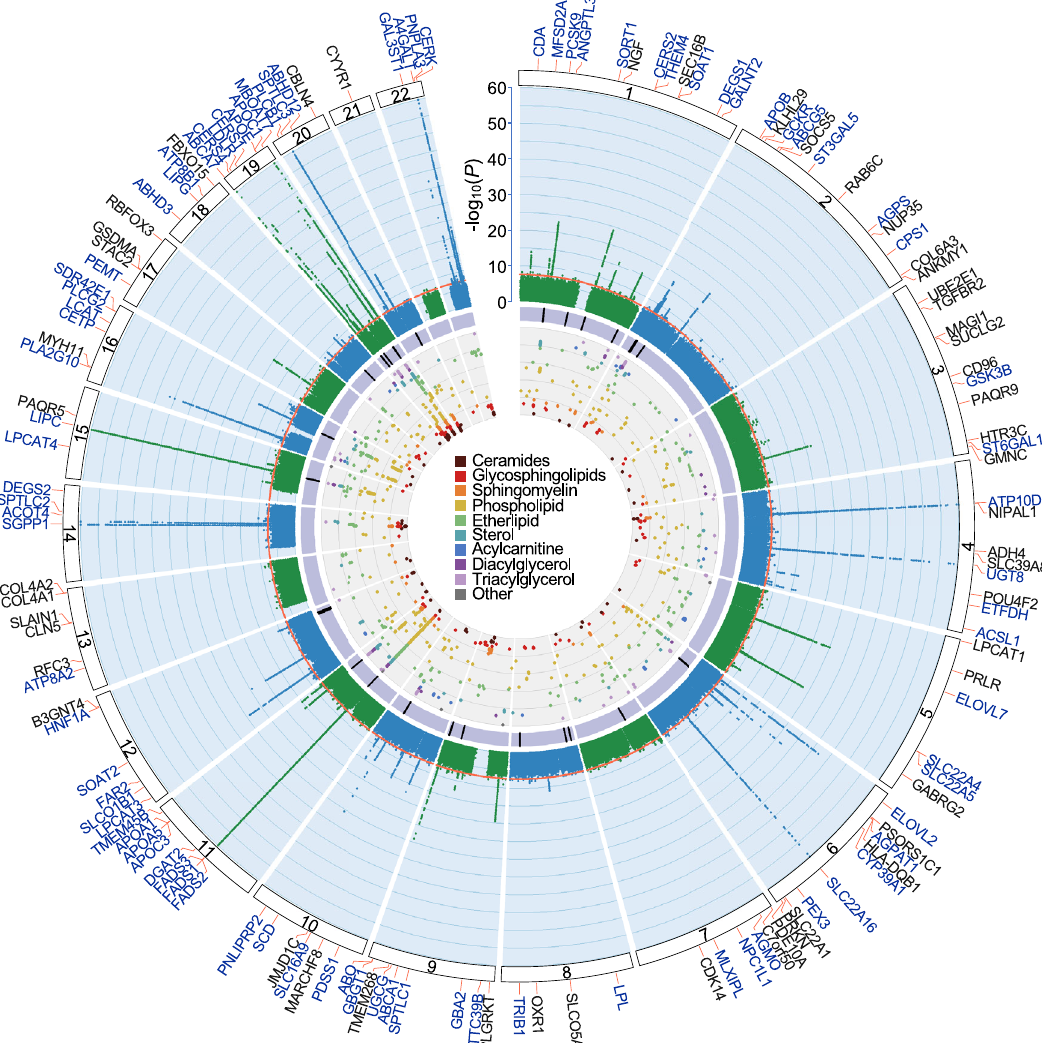
Fig. 2 Circular presentation of loci associated with circulating lipid species identi fi ed in our Discovery GWAS. The − log 10 ( P ) for genetic association with lipid species are arranged by chromosomal position, indicated by alternating blue and green points. Association P -values are truncated at P < 1 × 10 − 60 . Genome-wide signi fi cance ( P < 5 × 10 − 8 ) is indicated by the red line. For details about signi fi cant associations, see Supplementary Data 2, 3. Genes identi fi ed in our candidate gene analysis are highlighted in blue, otherwise the closest gene is indicated in black. The purple band indicates lipid-loci that co-localise with coronary artery disease (CAD) or show association with CAD after adjusting for clinical lipids. The inner circle shows a Fuji plot of SNP-lipid associations, coloured by broad lipid category. Colour keys representing broad lipid categories are indicated in the plot centre. Chromosomes are indicated by numbered panels 1 –